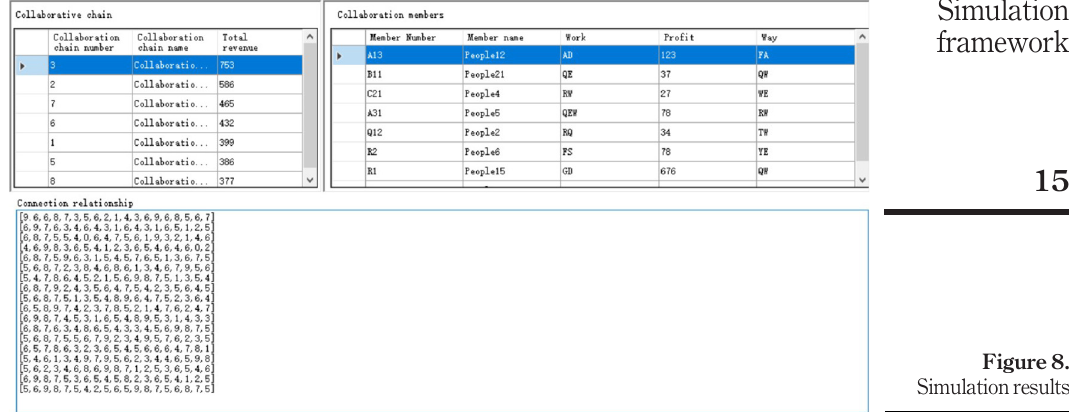
Figure 8. Simulation